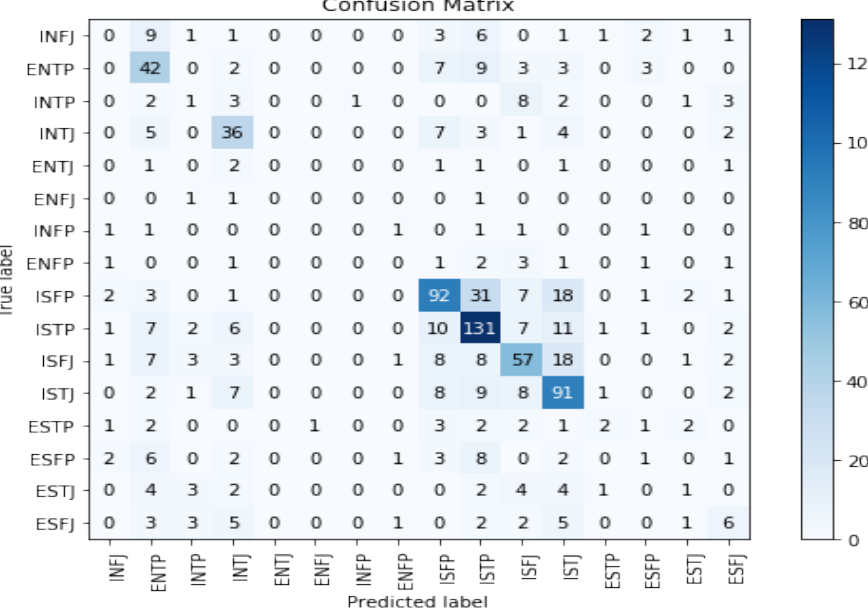
Figure 8. Model comparison: ( a ) Support vector machine, ( b ) Random forest, ( c ) Decision tree, ( d ) Loss vs. Epocs Graph. Table 2. Comparisionof different classifiers.